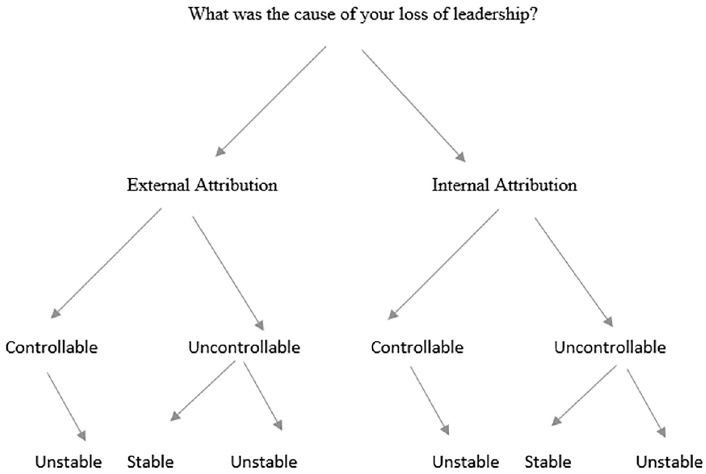
Figure 1. Three-dimensional attributional causality towards political